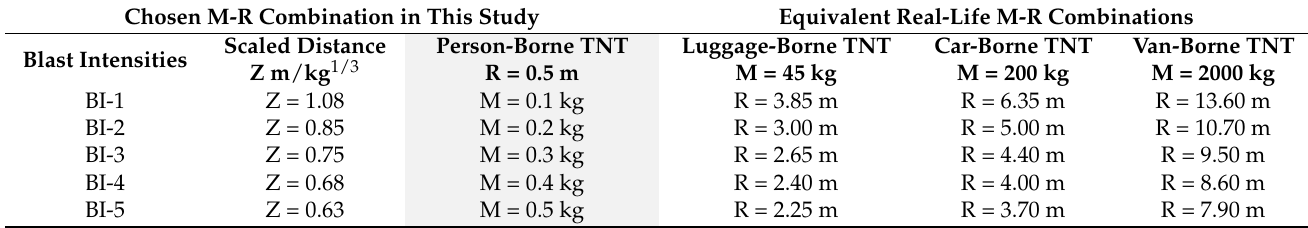
Table 2. The five blast intensities considered in this study, their scaled distances Z, and equivalent real-life M-R combinations (Mass is in Kg of TNT or its equivalent, stand-off distance R is in m). The highlighted column represents the considered M-R combination in this study.